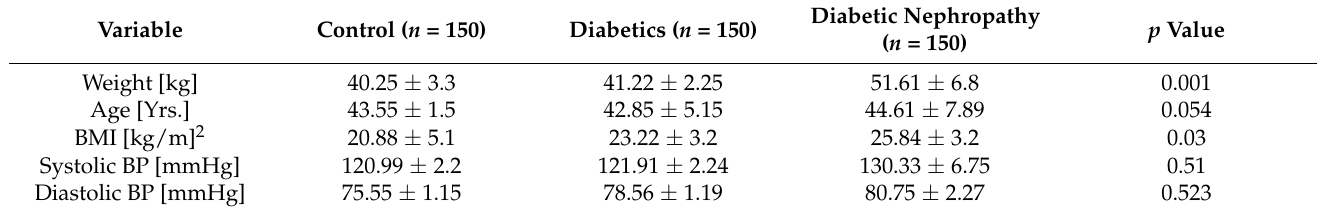
Table 1. Demographic profile of diabetics, diabetic nephropathy. Subject vs. healthy age matched control.